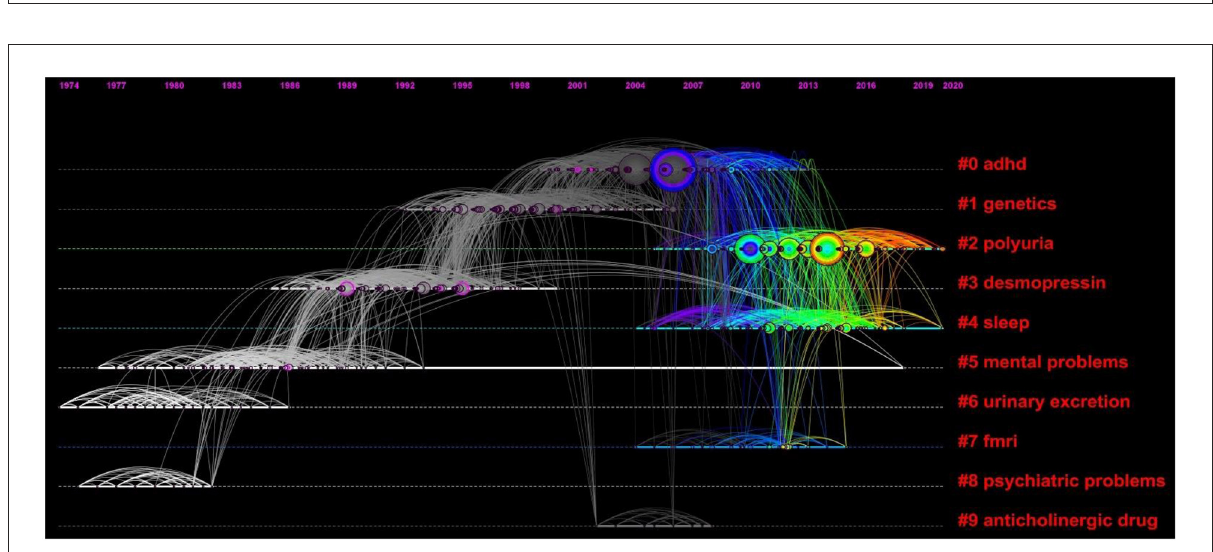
FIGURE10 Timeline view of the top 10 largest clusters of citing articles in the field of NE. The highlighted and thickened timeline indicates that the cluster theme is a hotspot during this period (Q = 0.6894, S =